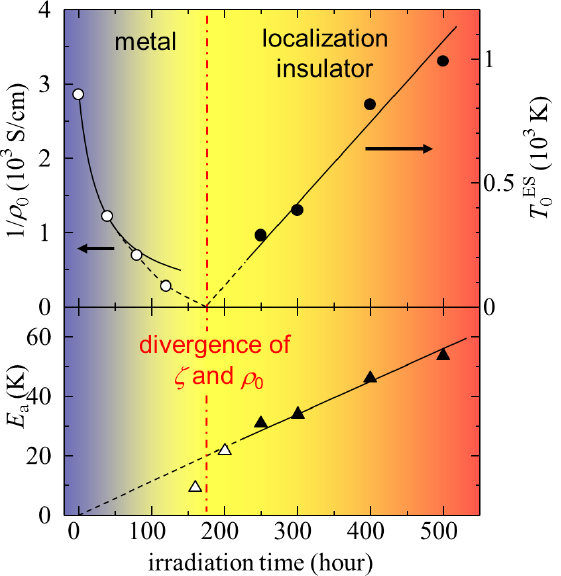
Figure 5. Irradiation time dependence of the residual resistivity ρ κ-(BEDT-TTF) Cu[N(CN) ]Br, T 0ES in the ES model and E 2 2 curve for 1/ ρ represents the linear dependence of ρ 0